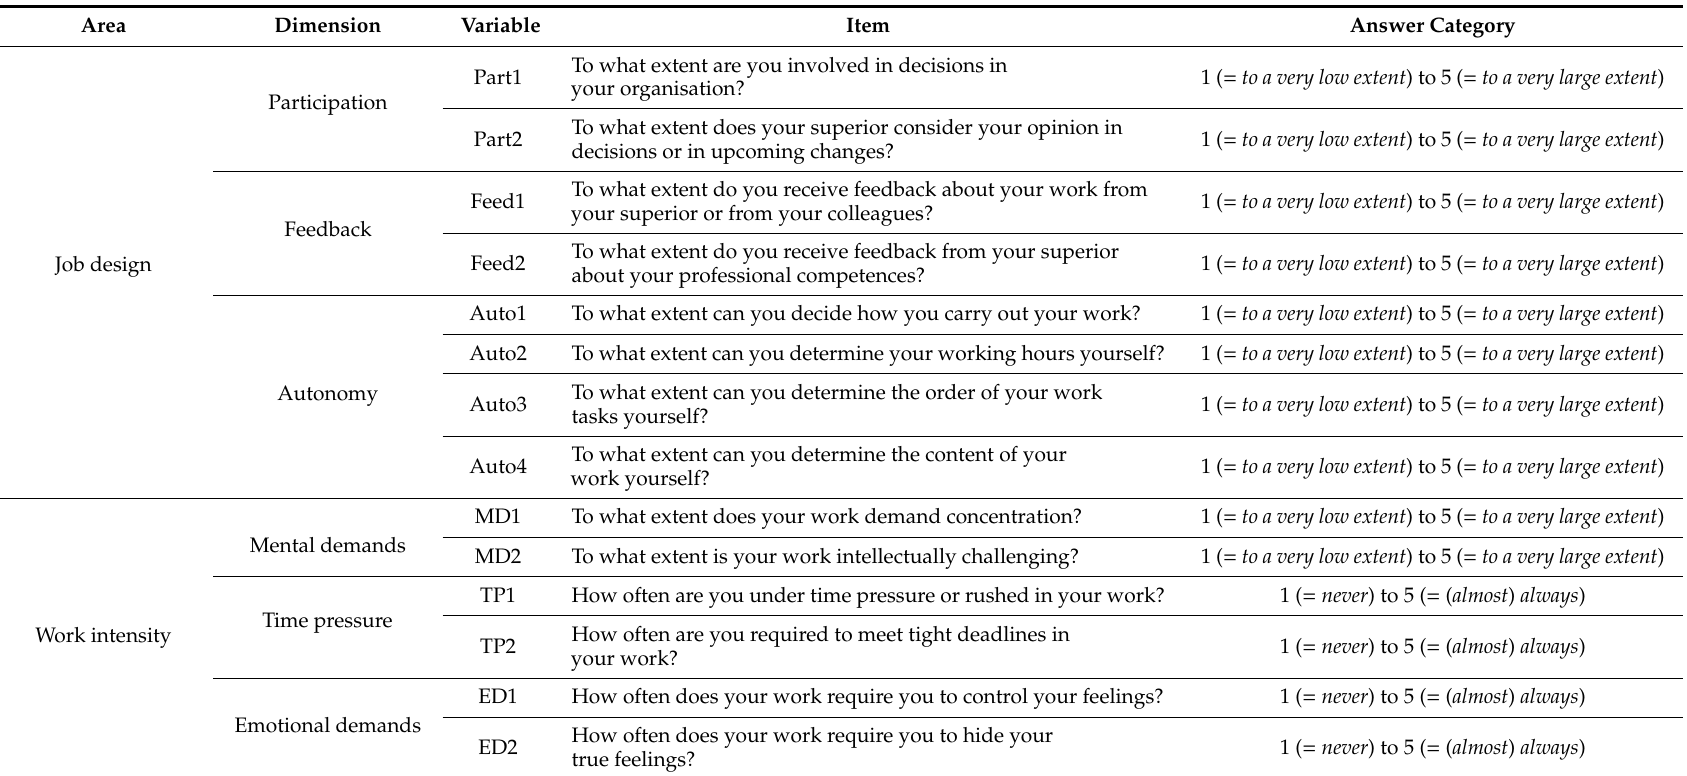
Table A1. Quality of Work